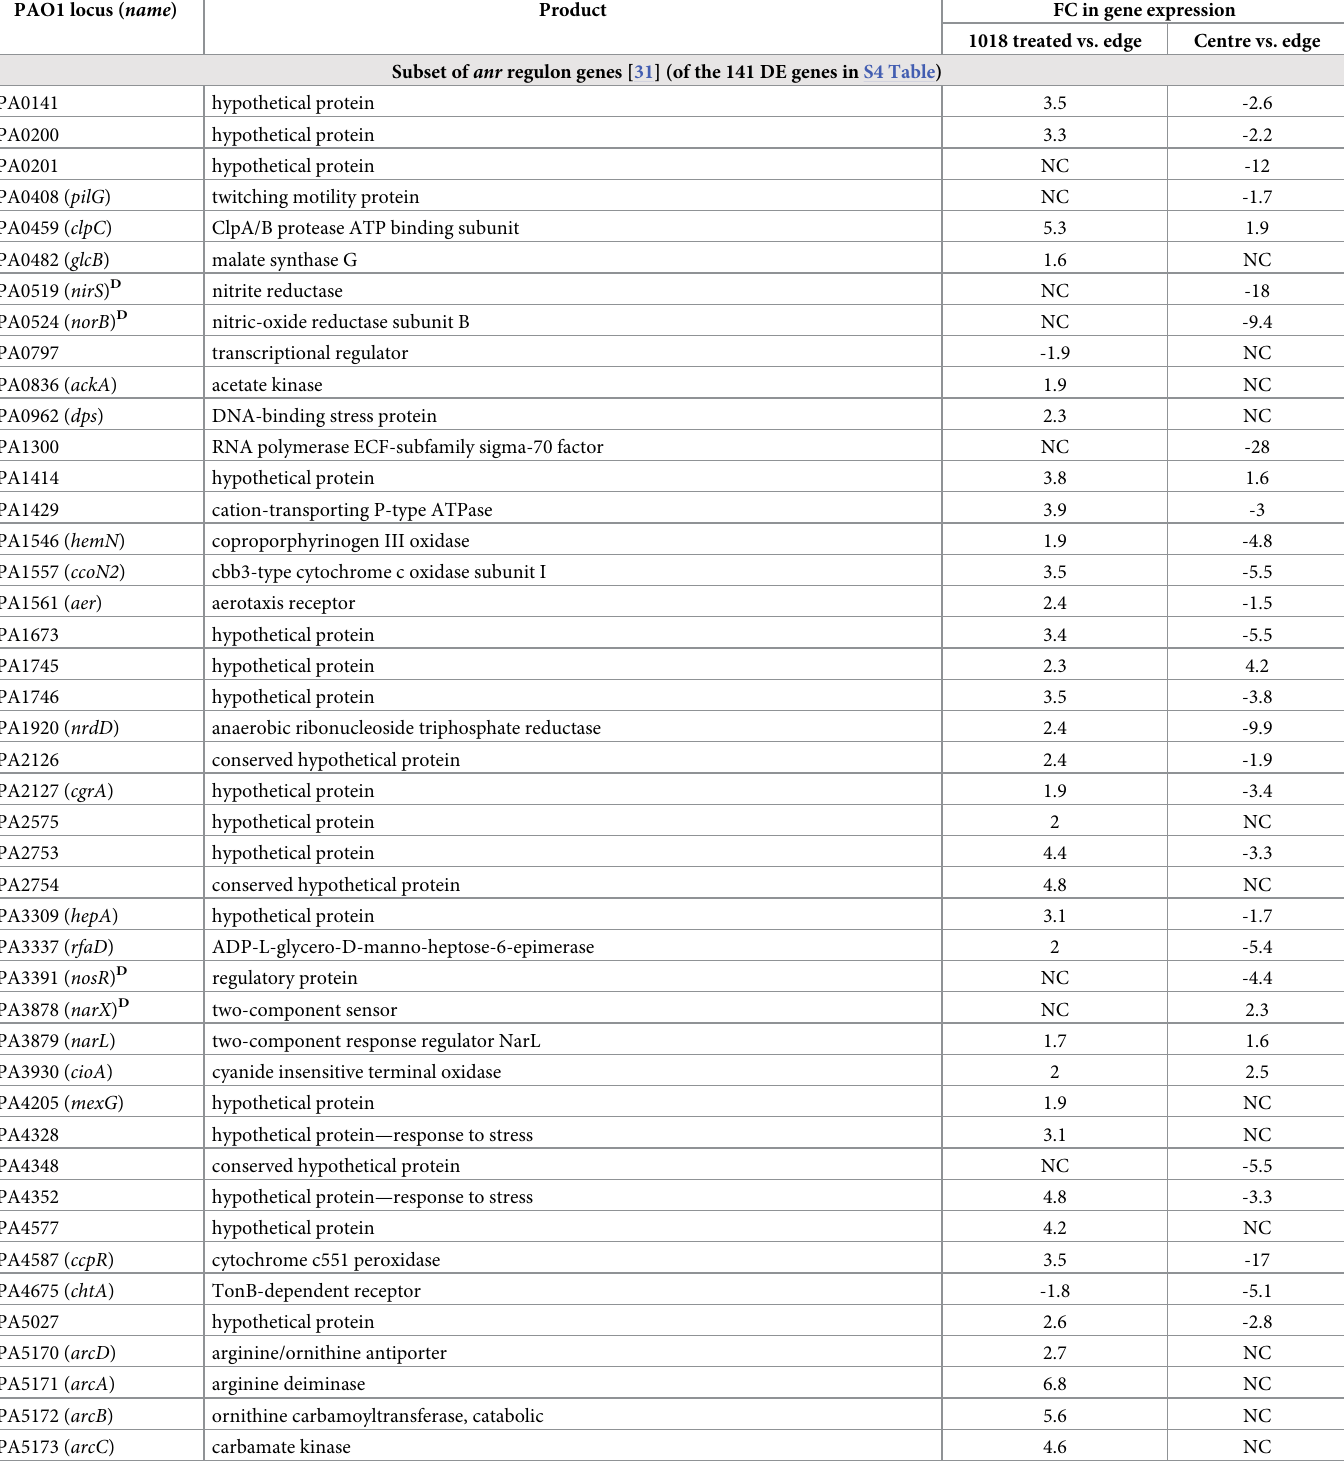
Table 1. Selected categories of DE genes, mapped to PAO1 orthologs, as determined by RNA-Seq in peptide-treated and swarming colony centre cells under swarm- ing conditions. PAO1 locus ( name